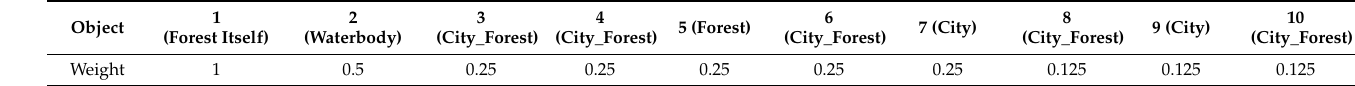
Table 6. Weights of all neighbor nodes.